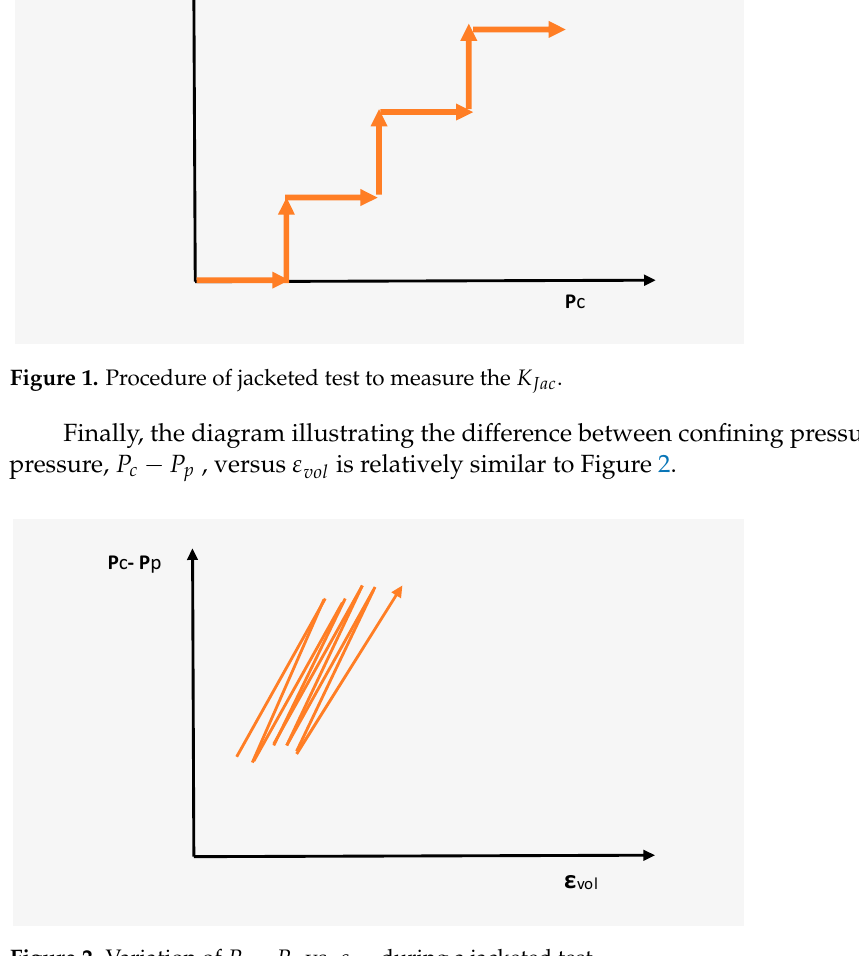
− 𝛼𝑃 versus 𝜀 can be ob- (cid:3030) (cid:3043) (cid:3049)(cid:3042)(cid:3039)